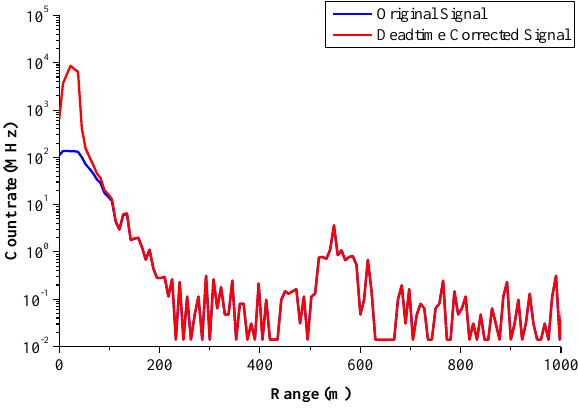
Figure 7. Results of dead time correction of PC signal.